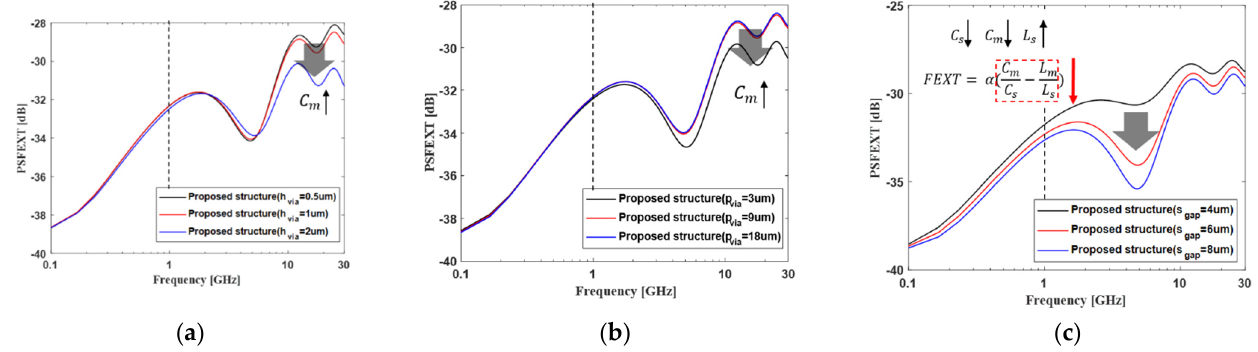
Figure 7. The PSFEXT analysis of proposed channel structure depending on the design parameters. ( a ) The height of the vertical tabbed via, ( b ) the pitch of the vertical tabbed via, and ( c ) the gap of the vertical channel.